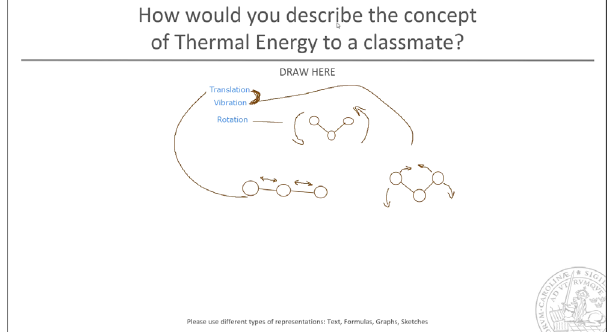
FIG. 6. Students discuss and solve the task together using the Zoom annotate function where they can draw and write using different shapes and colors. In the above example, two students discussed “ How would you describe the concept of thermal energy to a classmate? ” and drew representations of molecules in